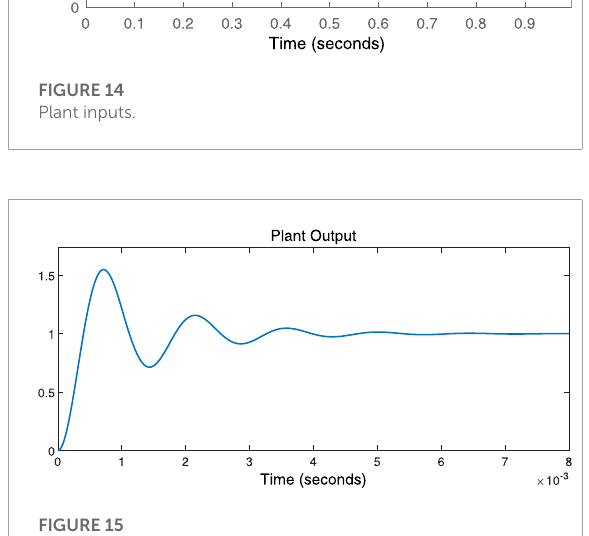
FIGURE 14 Plant inputs.